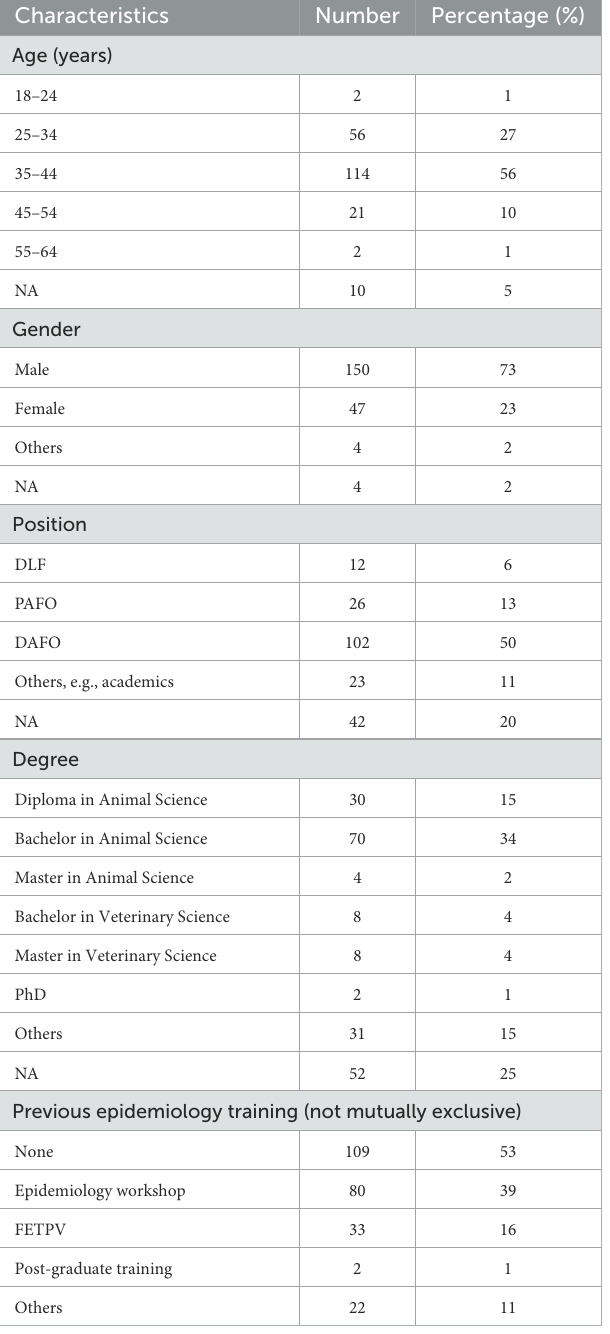
TABLE 1 Demographic characteristics of the Lao PDR animal health workforce respondents participating in the field veterinary epidemiology capacity online cross-sectional study between February and March 2021 ( n =